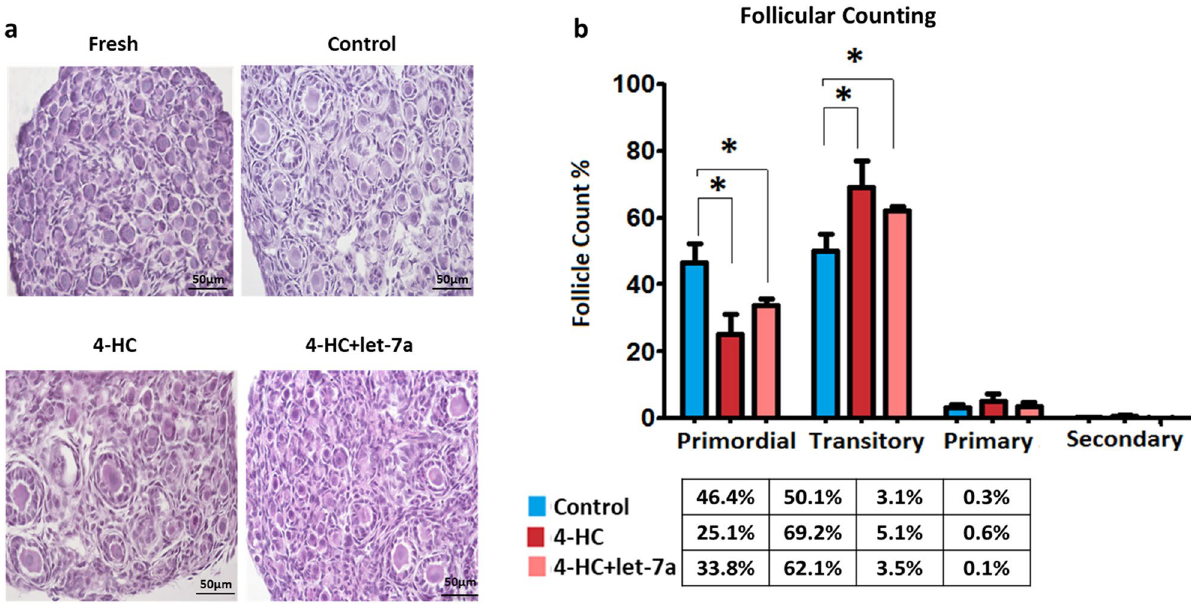
Figure 2. ( a ) Hematoxylin & Eosin (H&E) staining of PND3 ovaries in different conditions: D0 fresh ovary, cultured control, 4-HC, and 4-HC + let-7a mimic (N = 4/condition). ( b ) Percentage of follicles in different developmental stages in the 3 groups: control, 4-HC and 4-HC + et-7a mimic. The error bars represent the standard error, * p <